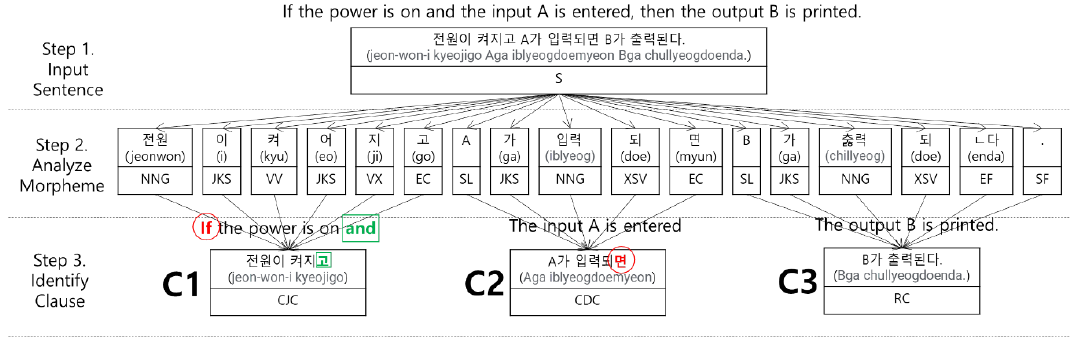
Figure 7. One example of identifying the priority of clauses in a simple sentence.